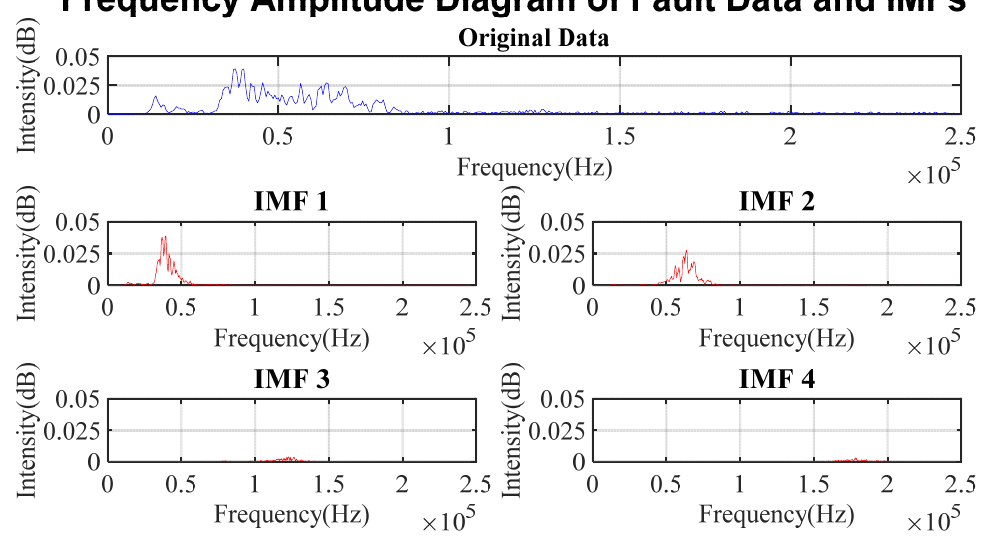
Figure 12. Spectrogram of IMFs when K = 4.